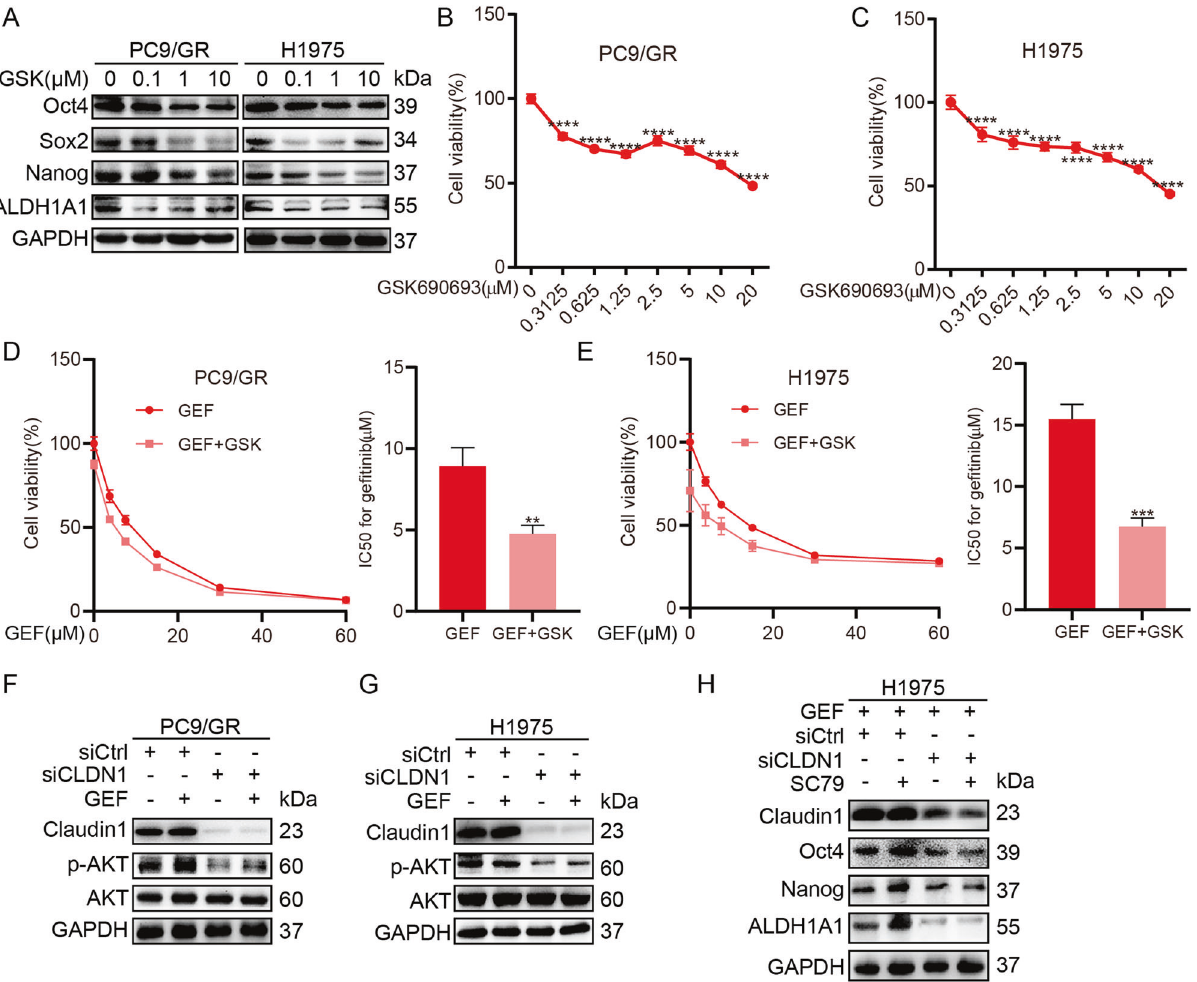
Fig. 5 AKT activation mediates the relevance between cluadin1 and CSC-like properties. A The expression levels of claudin1 and pluripotent markers were detected after PC9/GR and H1975 cells had been treated with GSK690693 for 48 h. B , C Effects of indicated concentrations of GSK690693 on cell viability of PC9/GR and H1975 cells. **** P < 0.0001 vs GSK690693 (0 µM). D , E Effects of GSK690693 (0.2 μ M) on ge fi tinib resistance in PC9/GR and H1975 cells as detected by the CCK8 assay, and the IC50 against ge fi tinib was determined. ** P < 0.01, *** P < 0.001. F , G PC9/GR and H1975 cells were transfected with siCLDN1 or siCtrl for 48 h, then treated with ge fi tinib (1 μ M) for 30 min, and expression levels of claudin1, p-AKT, and AKT were determined by western blotting. H H1975 cells were transfected with siCLDN1 or siCtrl for 6 h, then cells were treated with ge fi tinib (1 μ M) and SC79 (2 μ M) for another 48 h after which the expression levels of claudin1, Oct4, Nanog, and ALDH1A1 were Fig. S6C and ShC). Expression levels of claudin1, Sox2, and ALDH1A1 in tumor tissues of 1,25D/ge fi tinib combination treatment group were decreased when compared to the single treatment group (Fig. 8D – G). Furthermore, claudin1 overexpression-induced increase in ge fi tinib resistance in H1975 cells was reversed by 1,25D treatment (Fig. 8H, I). These results indicate that 1,25D inhibits ge fi tinib resistance by inhibiting claudin1 and AKT activation mediated cancer cell stemness.